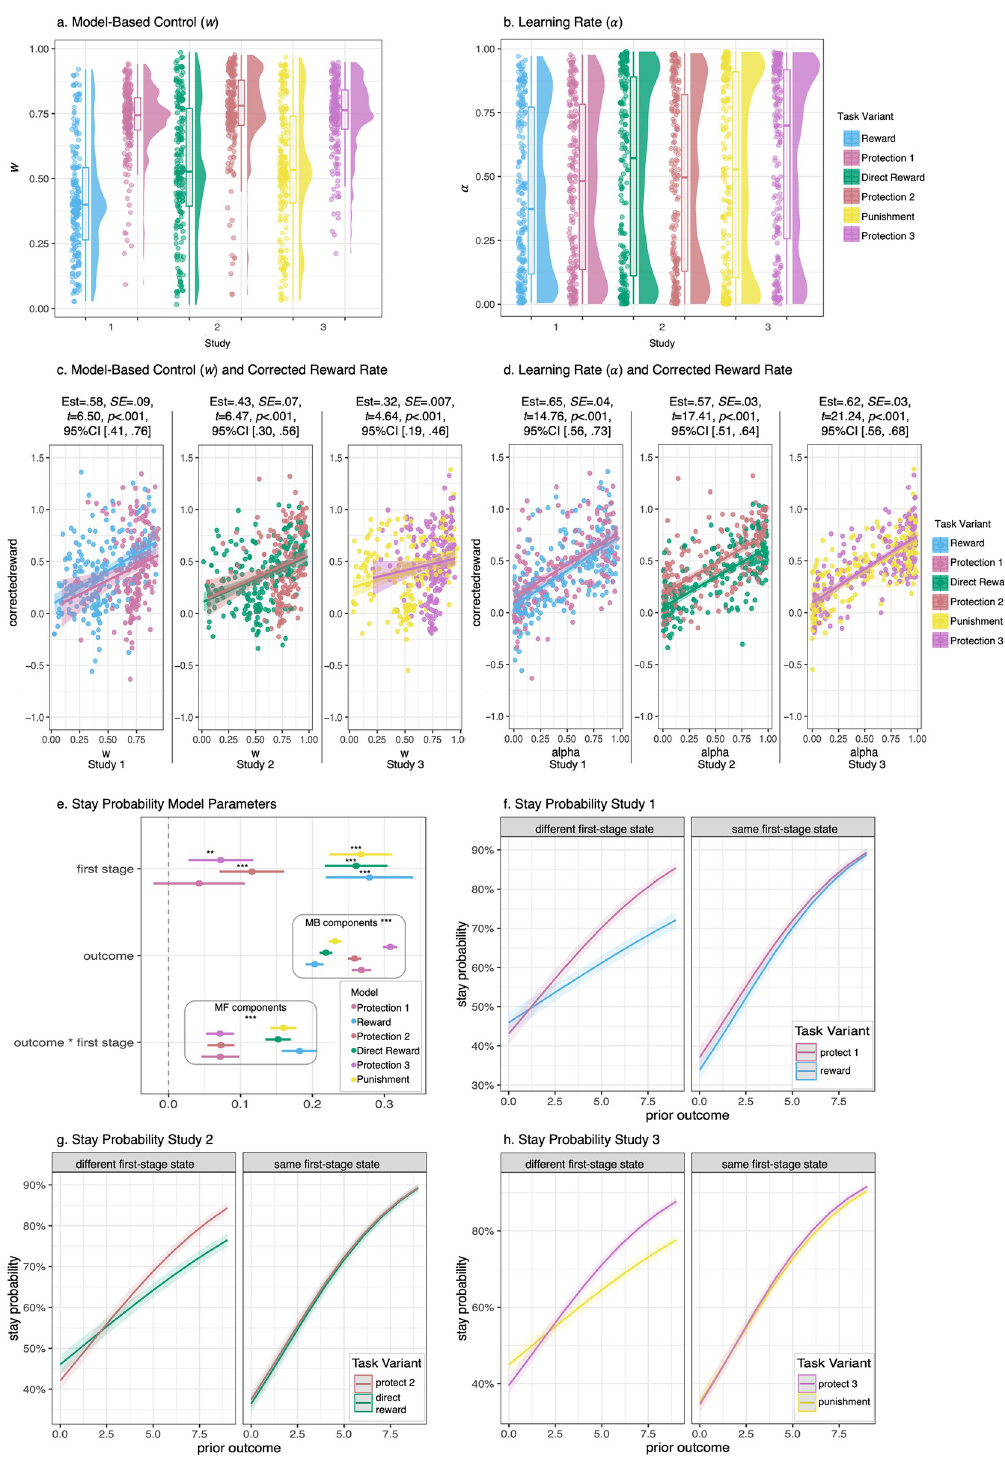
Fig 2. Model-Based Control and Learning Rate Results. a-b. Raincloud plots depicting model-based control weighting ( ω ) and learning rate ( α ) by study and task variant. ω was significantly higher for the protection variants compared to all other task variants. α did not significantly differ across task variants. Far right legend indicates task variants across all studies: Study 1 = Reward and Protection 1, Study 2 = Direct Reward and Protection 2, Study 3 = Punishment and Protection 3. c-d. Scatterplots and linear regression lines depicting positive associations between both ω and α with corrected reward rate